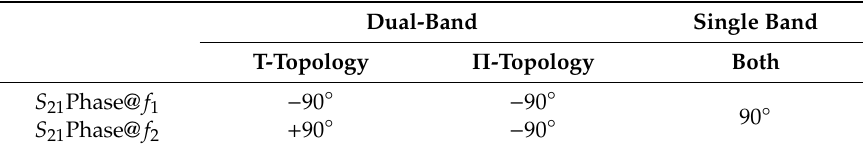
Table 1. Phase delay introduced by T- and Π -networks